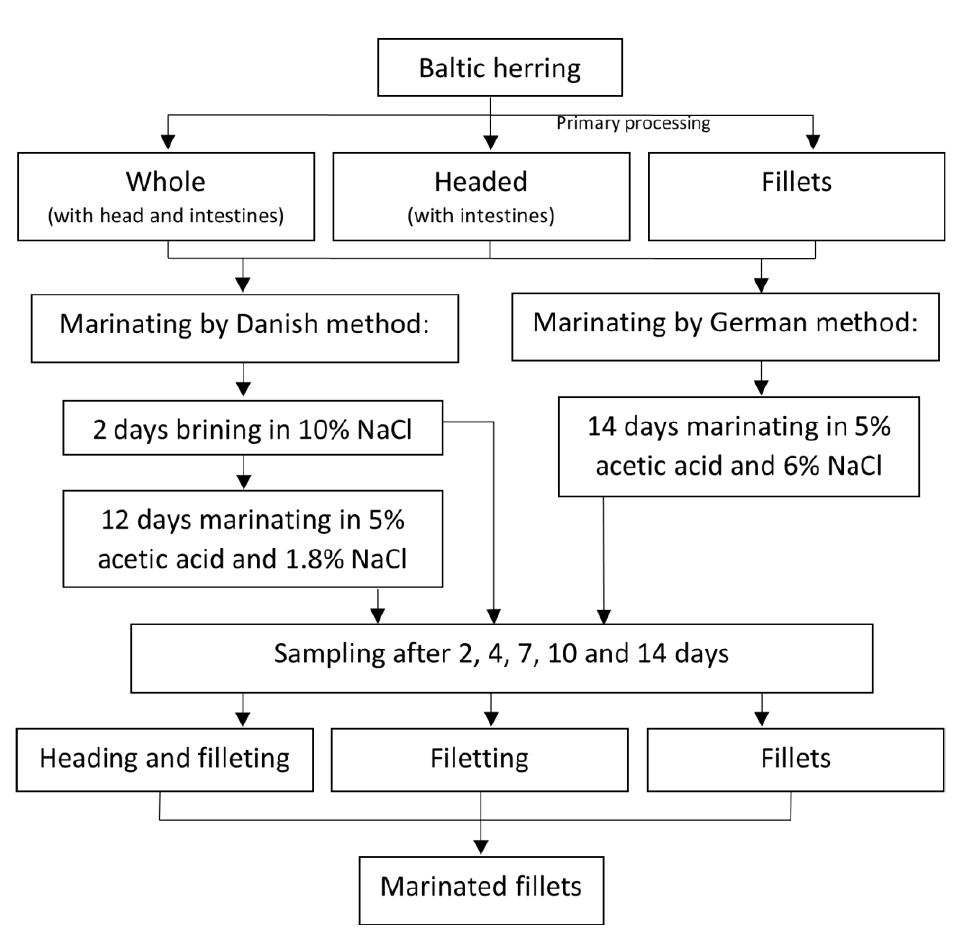
Figure 1. Diagram showing the performance of marinades using the German and Danish methods.